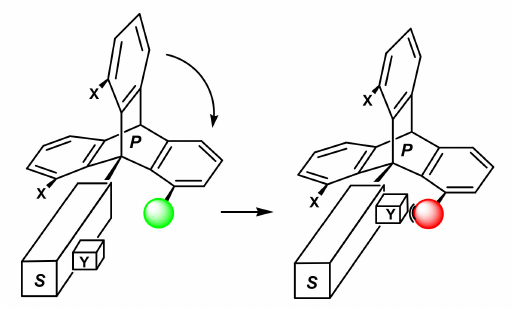
Figure 4. Schematic of a molecular gearing system in which free rotation of the paddlewheel P is controlled by sliding the “latch” Y of the shuttle S.